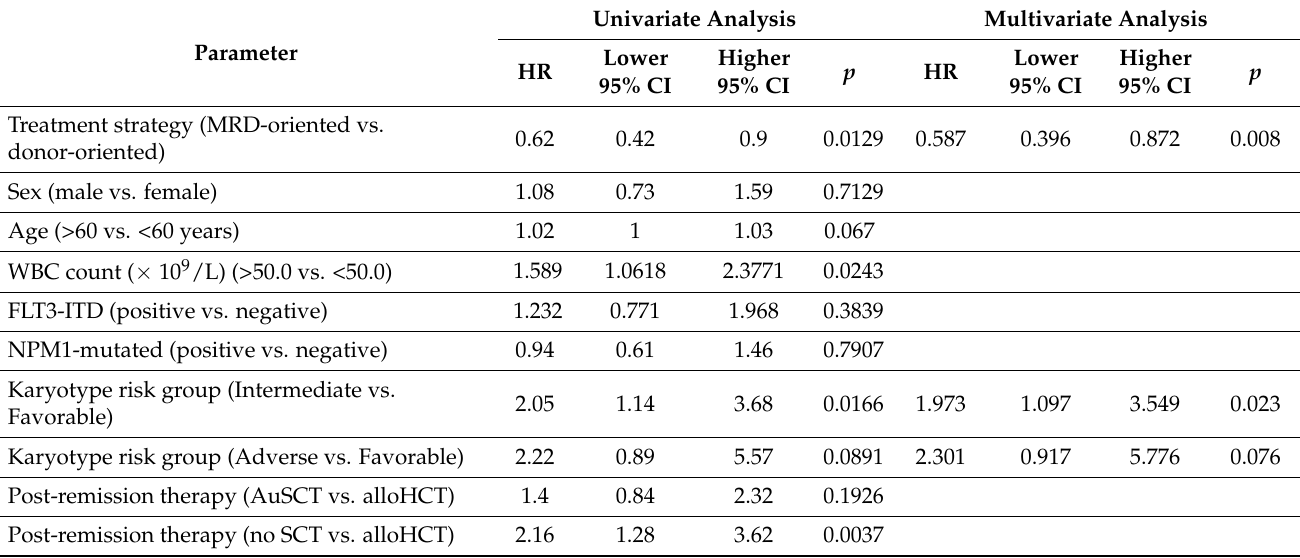
Table 2. Univariate and multivariate analysis for Overall Survival.